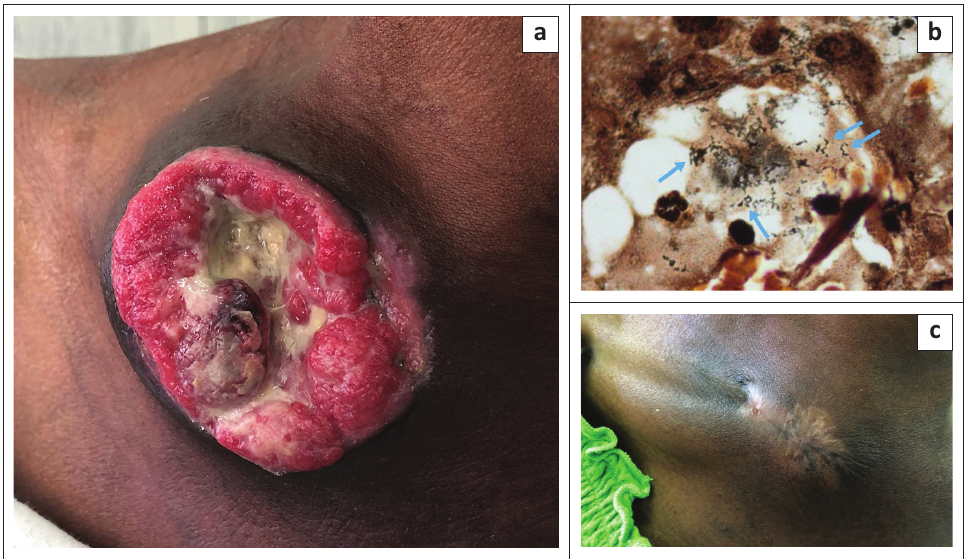
FIGURE 1: (a) The 20 cm ulcerating bacillary angioma. (b) Warthin-Starry stain highlighting clumps of bacilli in keeping with Bartonella species. (c) Resolution of the lesion following 9 weeks of therapy.